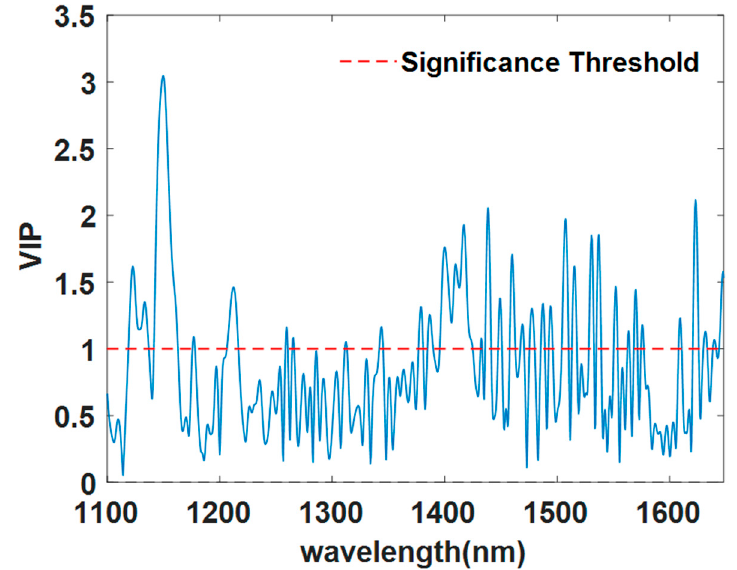
Figure 7. VIP scores of PLS on NIR data for lipids content.